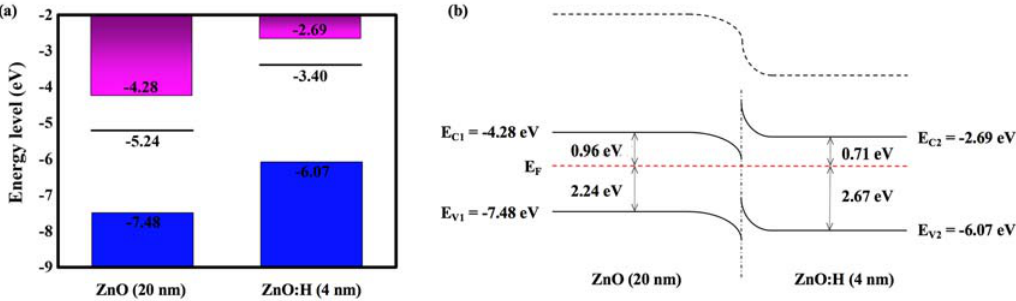
Figure 8. UPS results near the cut ‐ off edge of high binding energy for ( a ) ZnO and ( b ) ZnO:H pre ‐ pared at H 2 /(Ar + H 2 ) = 0.13%; UPS results near the cut ‐ off edge of low binding energy for ( c ) ZnO and ( d ) ZnO:H prepared at H 2 /(Ar + H 2 ) = 0.13%.